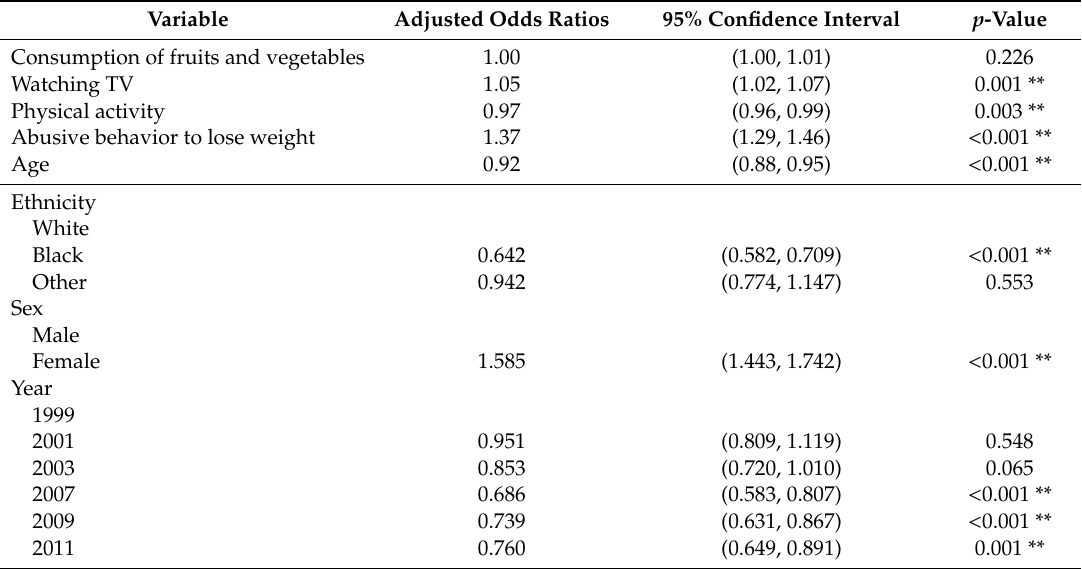
Table 3. Multivariate logistic regression to identify the factors associated with students’ overweight status. Variable Adjusted Odds Ratios 95% Confidence Interval p -Value Consumption of fruits and vegetables 1.00